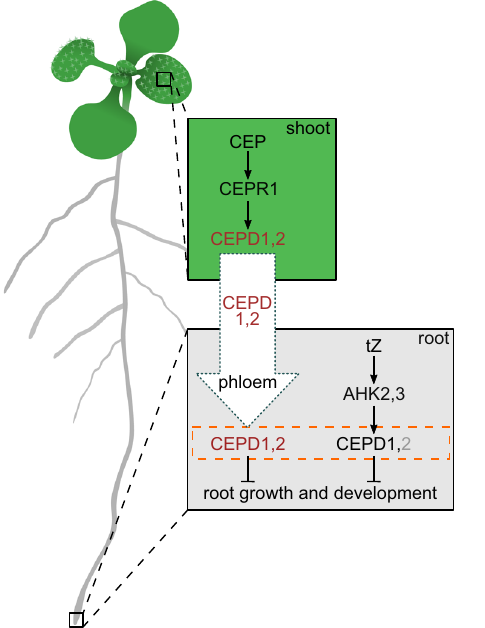
Fig. 7 | CEP peptide and cytokinin pathways converge on CEPD glutaredoxins to inhibitroot growth. Intheshoot, the perceptionofroot-derivedCEPby CEPR1 results in increased CEPD1,2 glutaredoxin production (red text). Shoot derived CEPD1,2 travels to the root via the phloem. In the root, t Z signals locally through AHK2,3 to transcriptionally induce local CEPD1 production (black text). It is pos- sible that t Z signals through CEPD2 (grey text) locally via other mechanisms (e.g. post-translationally). The pool of shoot- and root-derived CEPD (orange box with broken lines) ultimately integrates root growth responses with whole-of-plant nutritional and environmental stress status. t Z trans -zeatin, AHK ARABIDOPSIS HISTIDINE KINASE, CEP C-TERMINALLYENCODEDPEPTIDE,CEPR CEPRECEPTOR, CEPD CEP